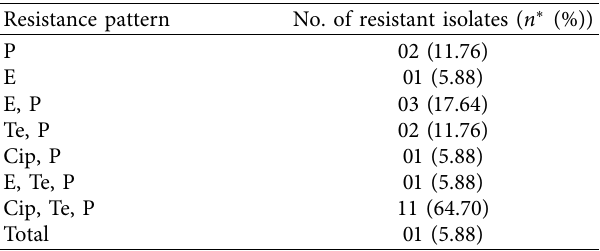
Table 1: Multidrug resistant pattern of the Staphylococcus aureus strains carried by